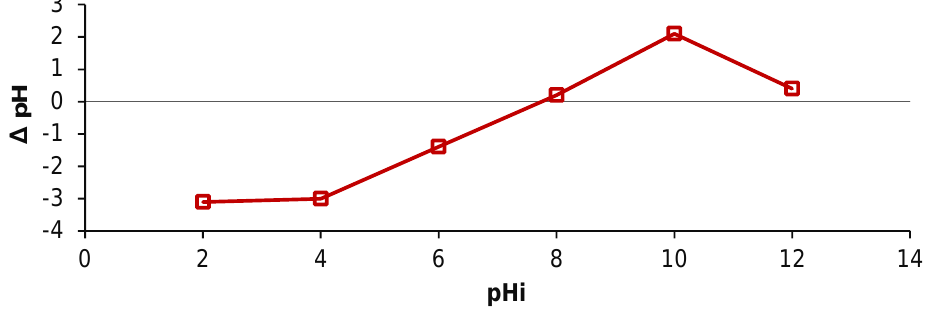
Figure 5. Point of zero charge of the prepared adsorbent.